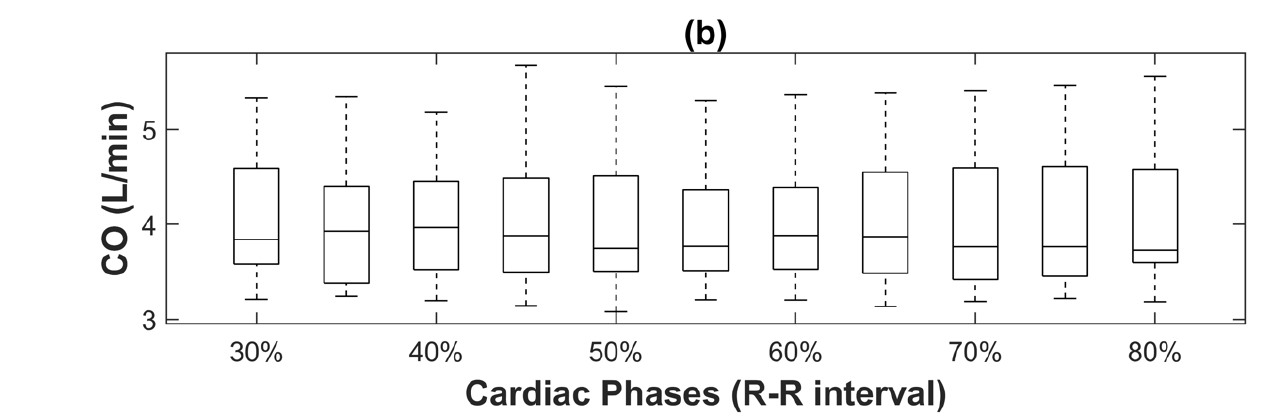
Figure 5. ( a ) Integrals of the fitted normalized aortic time-enhancement curves at different cardiac phases in 17 CT myocardial perfusion studies. Curve fitting was performed by using a modified gamma variate function (MVGF) and the fitted curve was normalized to a single baseline point unaffected by streak artifacts. The crosses in the boxplot represent outliers. Both the integrals and the corresponding CO indexes shown in ( b ) were not statistically different among different cardiac phases.